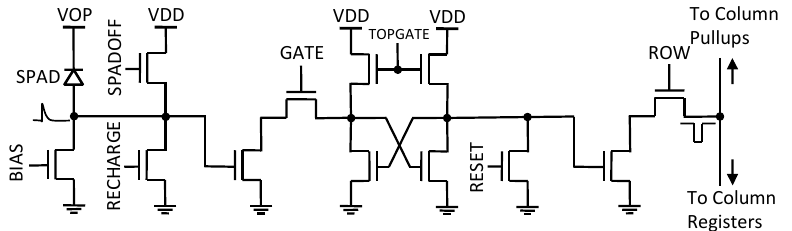
Figure 3. Pixel schematic. The counter is implemented as a latch, which is reset by “RESET” and biased by “TOPGATE“. The content of the counter is read out using a rolling shutter mechanism by setting “ROW” to “H“; when the counter has recorded a photon, a pull-down transistor sets the column to “L” and this state is transferred to a latch at the bottom of the column (not shown in the figure) and then to a PAD via a multiplexer for external processing. A pull-up ensures return of the column to “H” state when no photons are detected. “RECHARGE“ and “SPADOFF“ are used to turn on and off the SPAD, while “GATE” is used as a pass gate and “BIAS” determines the equivalent resistance used as ballast.